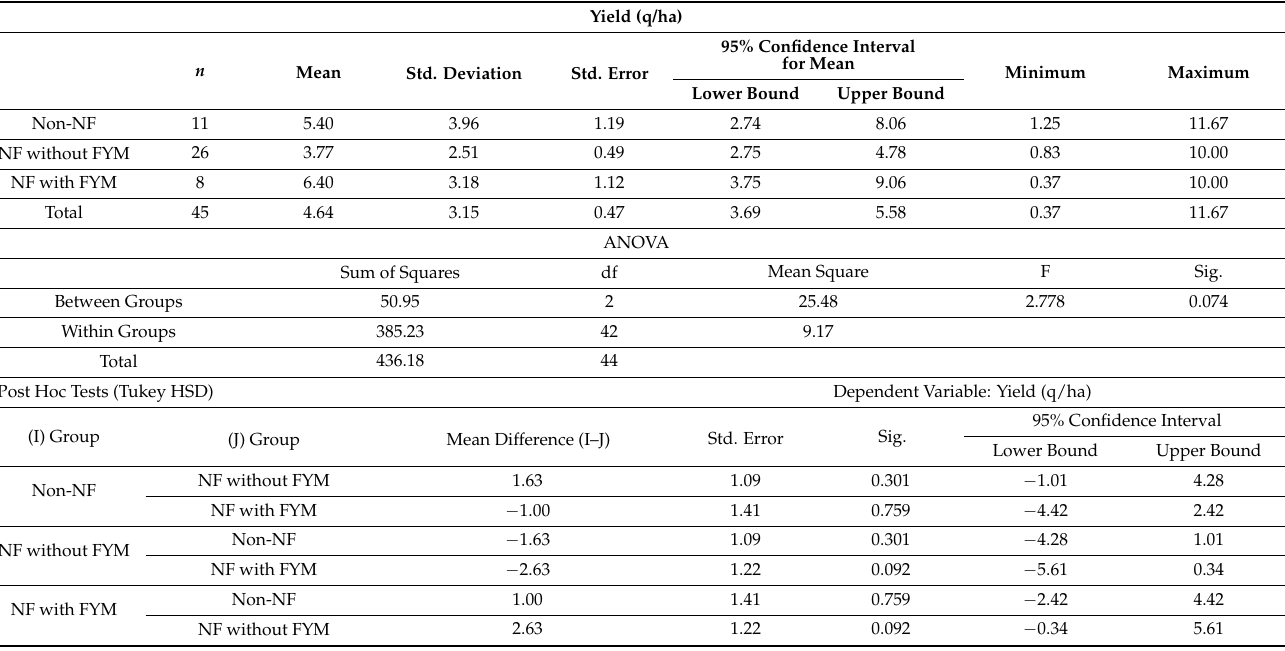
Table A1. ANOVA result of yield comparison for black gram in Andhra Pradesh.